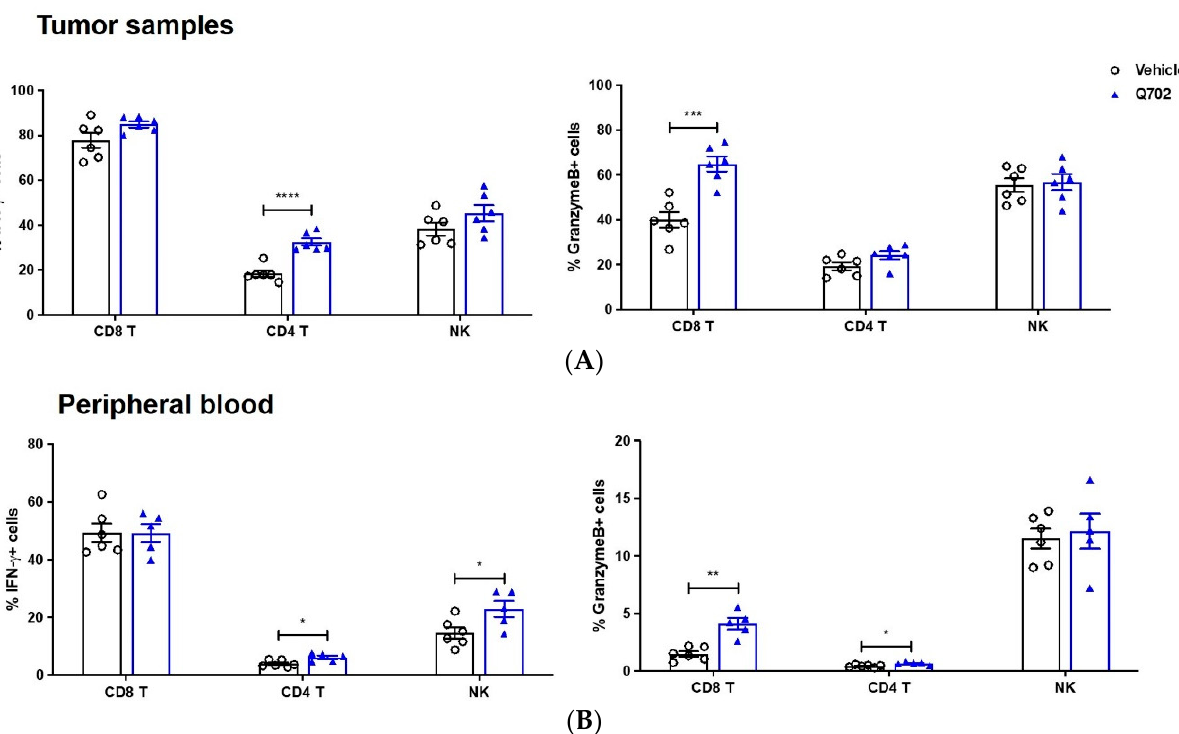
Figure 5. Q702 enhances effector function of T and NK cells in peripheral blood as well as in tumor samples. EMT6 (1 × 10 6 ) cells were inoculated subcutaneously into the left flank of BALB/c mice. When the tumor size reached 110 mm 3 , mice were randomized and treated with vehicle or Q702 (30 mg/kg) orally once daily for 7 days. Tumor and peripheral blood samples were collected 4 h after the last dose. Cells from tumor samples ( A ) or blood cells ( B ) were stimulated with PMA + Ionomycin for 4–6 h and then stained for IFN- γ or granzyme B detection. Graphs show the percentage of IFN- γ - or granzyme B-producing CD8 T, CD4 T, or NK cells. * p < 0.05, ** p < 0.01, *** p <